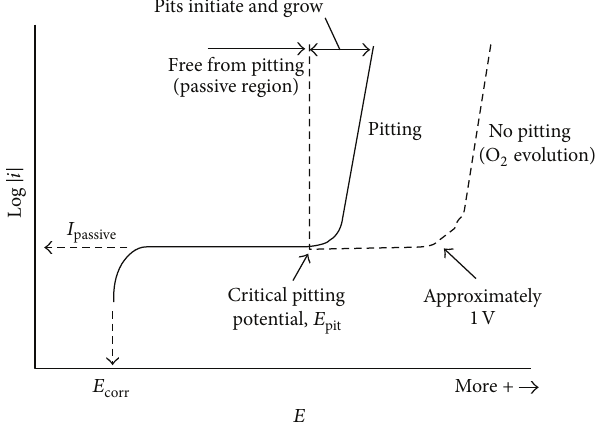
Figure 3: Schematic anodic polarization curve showing the critical pitting potential (for a passive metal) [38].